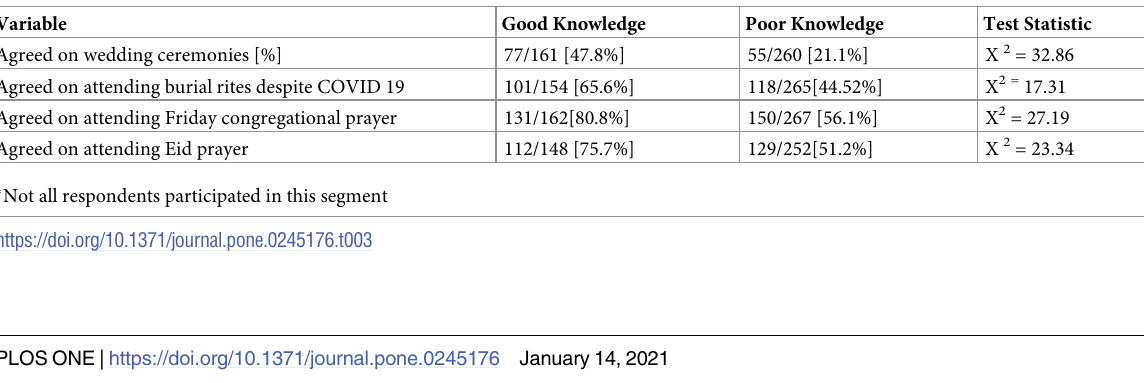
Table 3. Relationship of COVID-19 knowledge to social and religio-cultural activities �